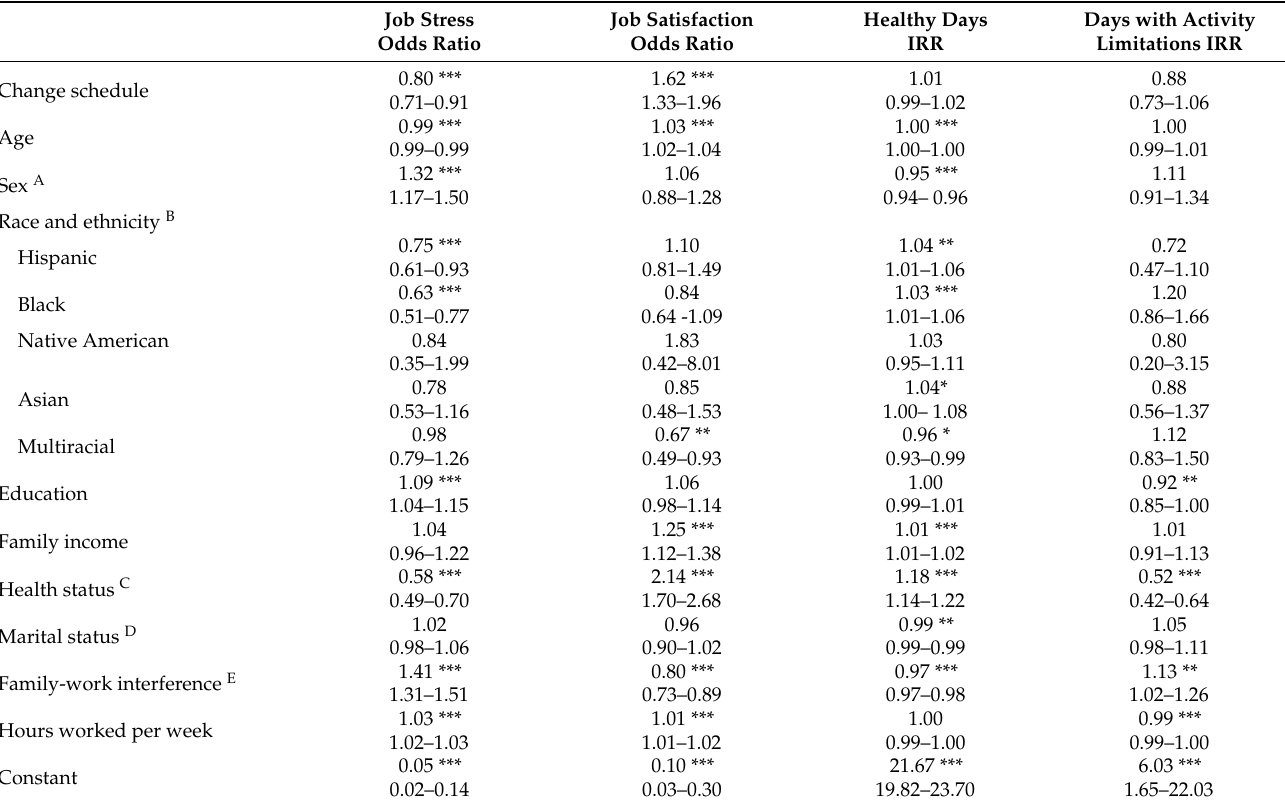
Table 7. Ability to change one’s schedule and well-being, pooled GSS-QWL data. Job Stress Odds